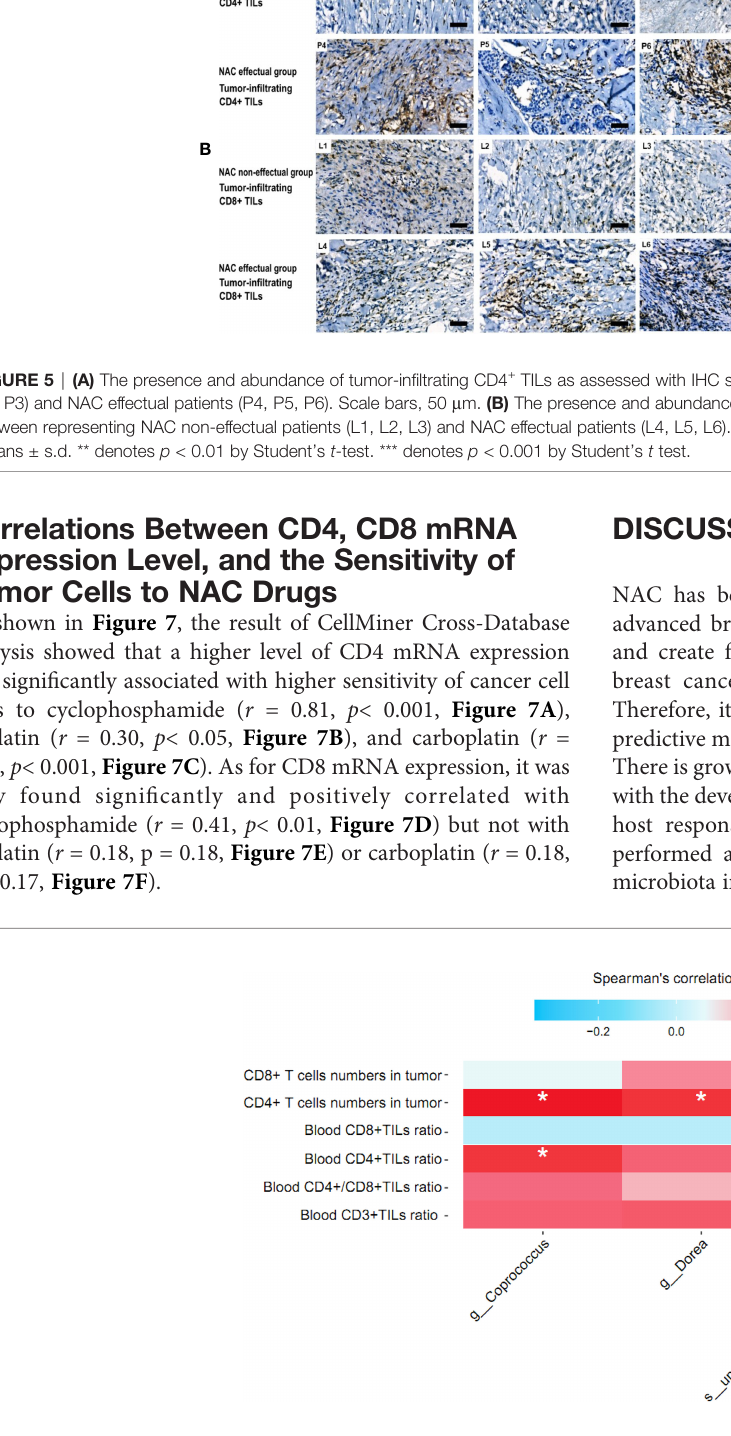
FIGURE 6 | Correlation between relative abundance of signature gut microbiota and T lymphocyte cell subsets in breast cancer patients treated by NAC. Partial Spearman ’ s rank correlation coef fi cient is indicated using a color gradient: red indicates positive correlation; blue, negative correlation. TIL, tumor in fi ltrating lymphocyte. * denotes p < 0.05.